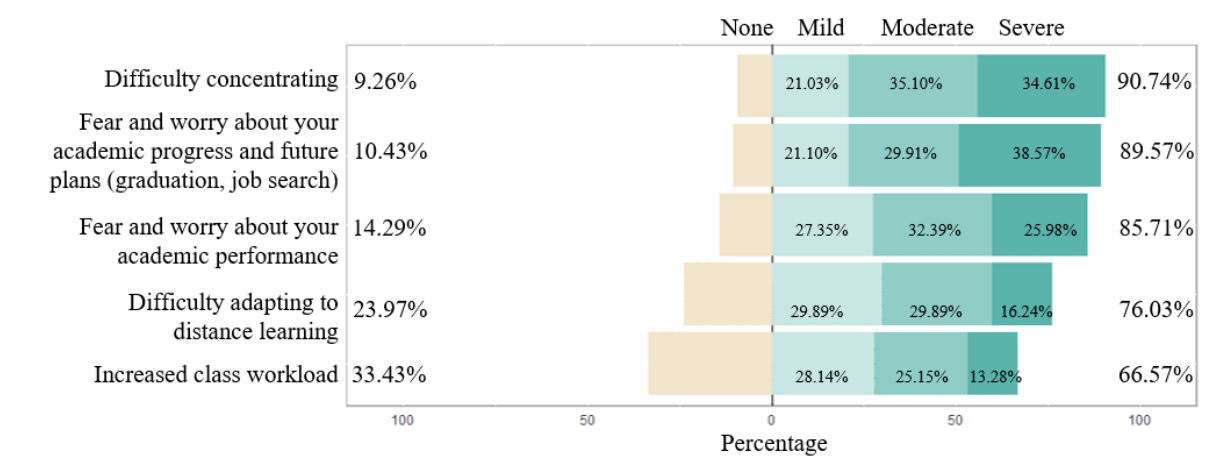
Figure 3. Academic-related